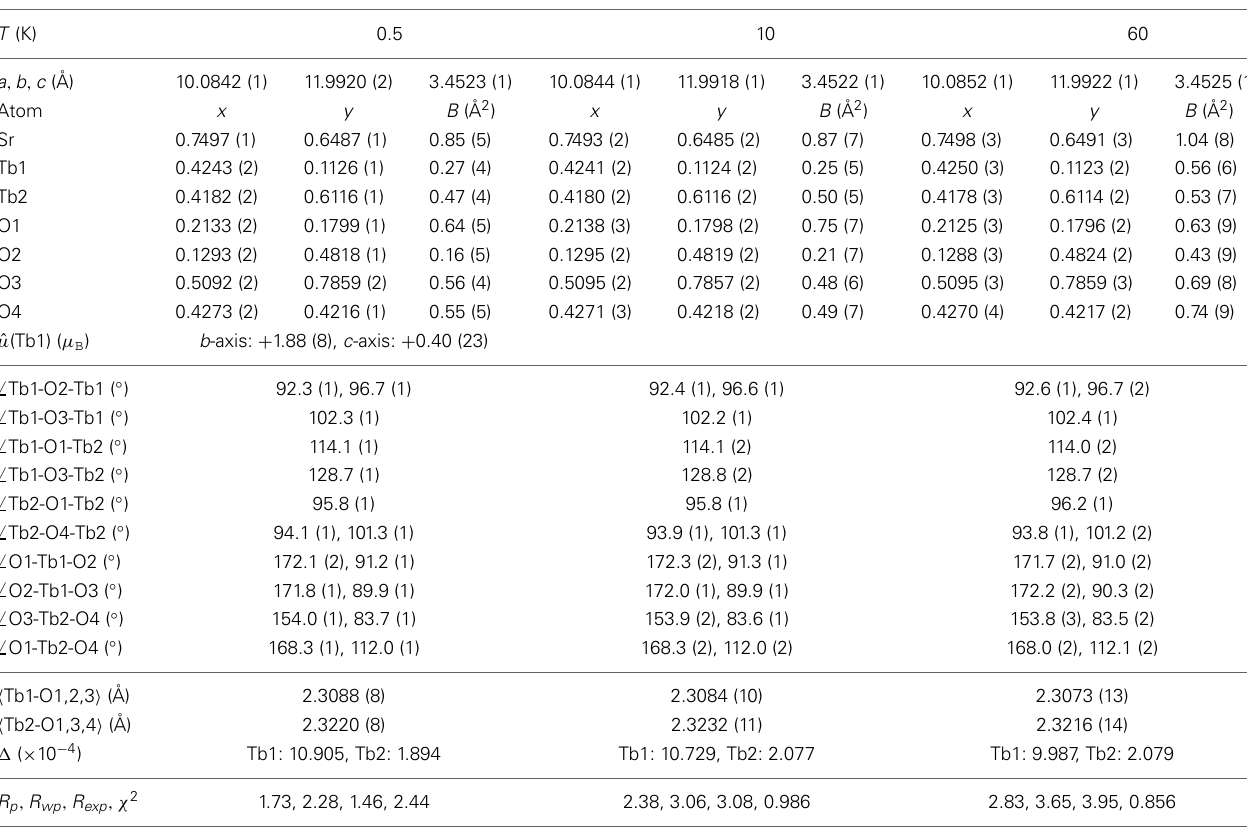
Table 1 | Refined structural parameters (lattice constants, atomic positions, Debye-Waller factor B , bond angles and bond lengths), magnetic moment ˆ µ , and the corresponding goodness of refinement by the Fullprof Suite [47] from the NPD data measured at 0.5, 10, and 60 K using SPODI